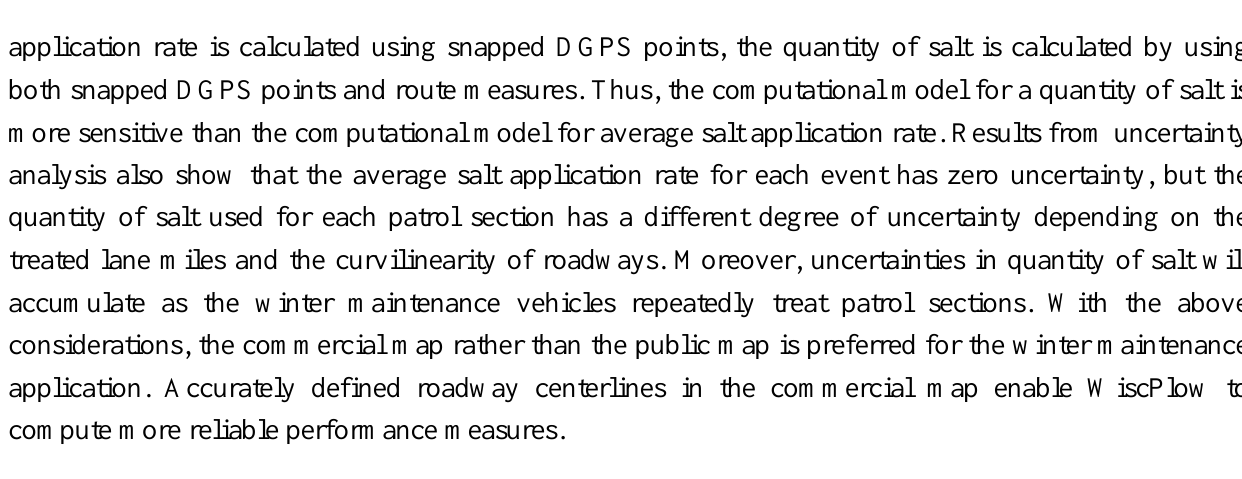
Table 6. Uncertainty analysis: “Average salt application rate.”